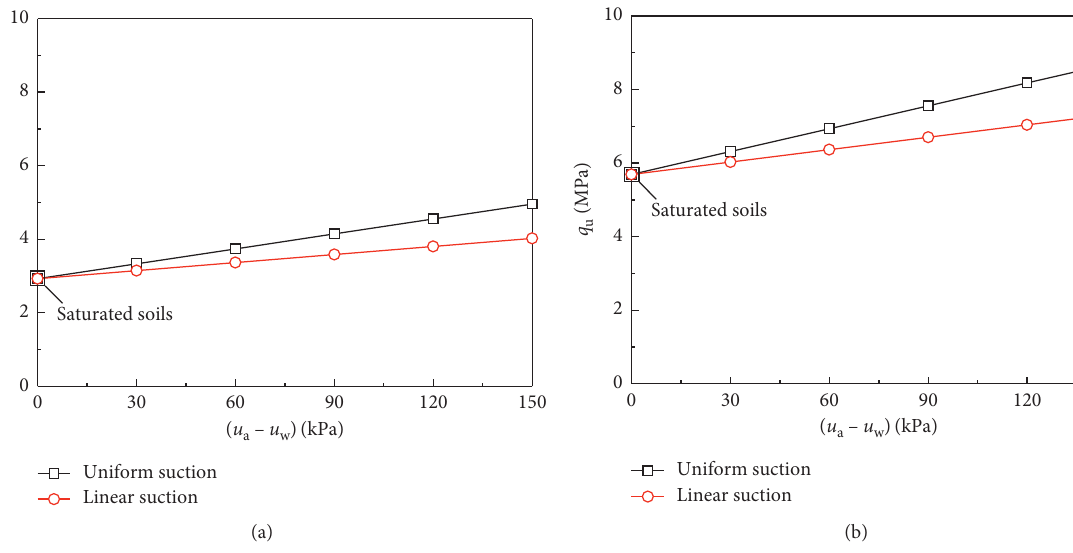
Figure 9: Effect of matric suction. (a) b � 0. (b) b � 1.